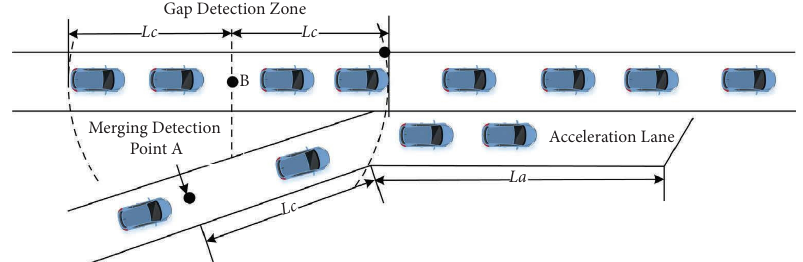
Figure 1: Description of the network.